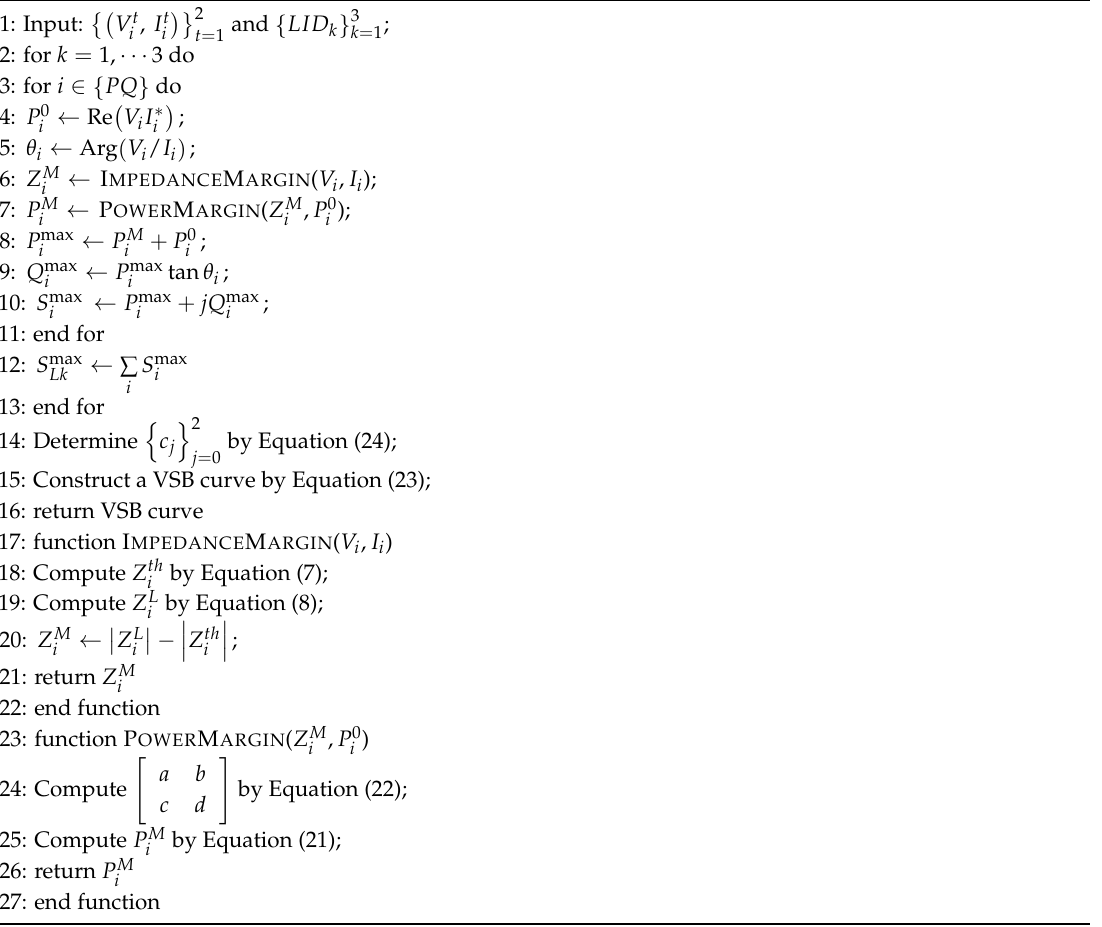
Algorithm 1. Construction of a VSB curve in P-Q plane.